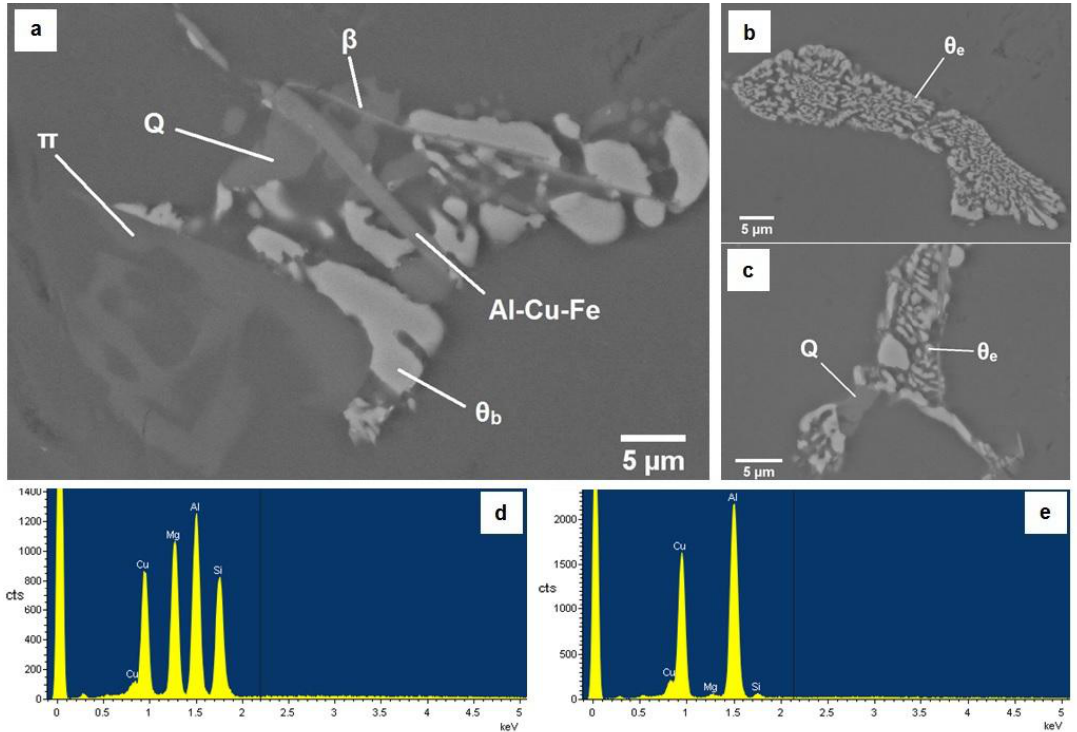
Figure 2. SEM images of typical intermetallic particles observed in the A354 as cast alloy: ( a ) different Cu-based intermetallics (blocky θ -Al 2 Cu, indicated as θ b and Q) and Fe-based particles ( β -Al 5 FeSi, π-Al 8 Mg 3 FeSi 6 ). ( b) θ-Al 2 Cu phase with eutectic morphology indicated as θ e . ( c ) θ-Al 2 Cu phase associated with the Q phase. EDS spectra of ( d ) Q and ( e ) θ phases in Figure 2c and readapted from Reference [21].